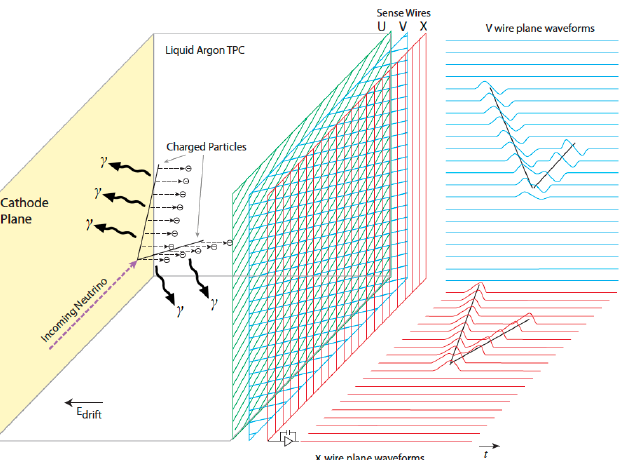
Figure 1. General operating principle of the SP LAr TPC. Charged particles from the neutrino interaction ionize the argon, and the ionization electrons drift horizontally towards the read-out wire planes. The right hand side of the image represents the time projections for two of the wire sets. Scintillation light is also produced and can be detected by photon sensors. From